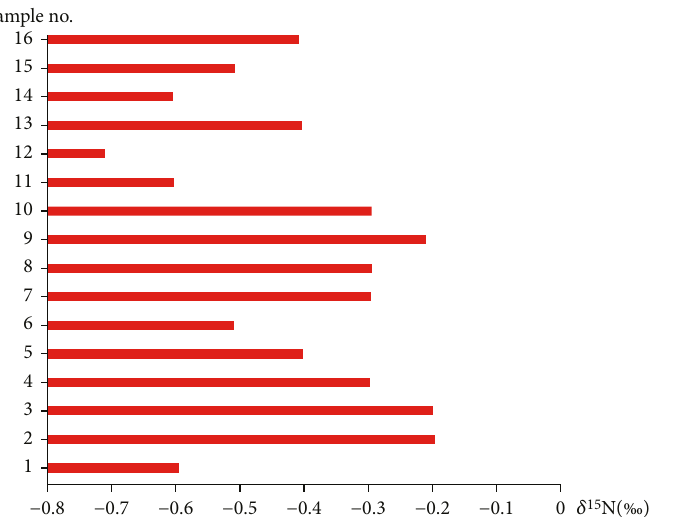
Figure 4: Gas components of the lower Cambrian Guanyintang and Wangyinpu formations of Jiangye-1. See Figure 1 for the location of the well location.